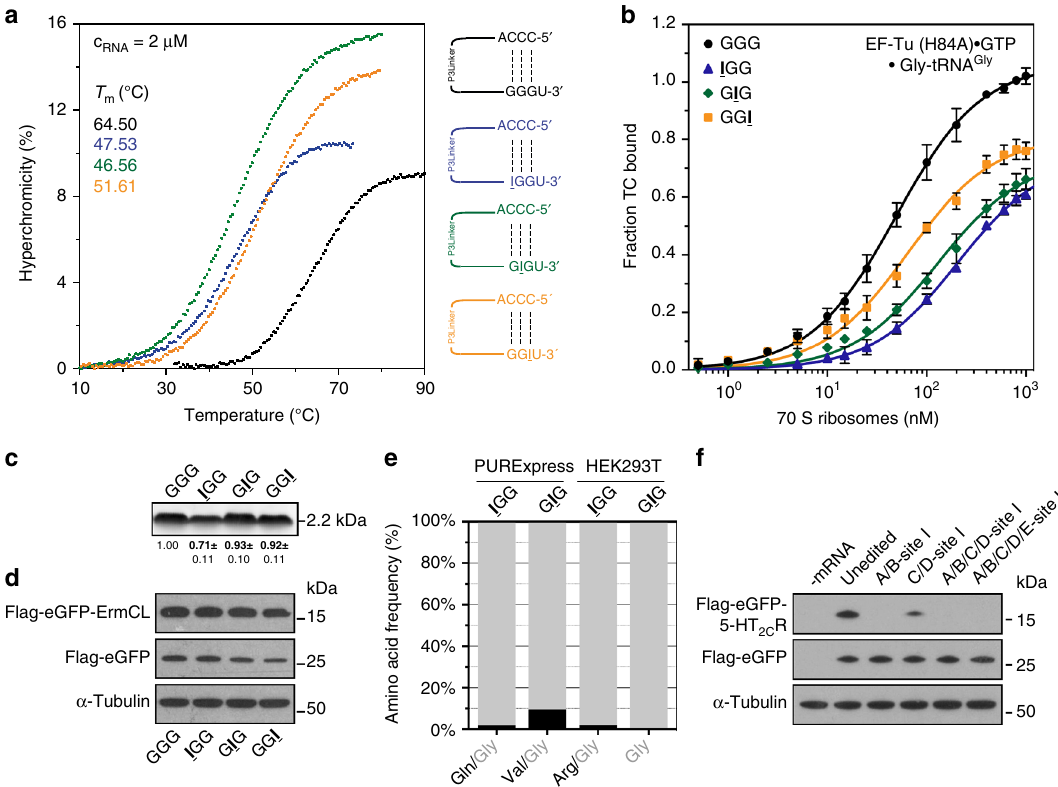
Fig. 5 The in fl uence of inosine on the stability of the codon – anticodon interaction. a Employing a minimal codon – anticodon model, the impact of a single inosine on the stability of the W – C interaction was determined. b The observed position-dependent effects on codon – anticodon interaction could be reproduced using an EF – Tu ternary complex (TC)-binding assay. mRNAs carrying single inosines were translated in c an E. coli translation system and d in HEK293T cells. e The translation products were puri fi ed and qualitatively assessed by mass spectrometry. f An additive inhibitory effect of two or more inosines within the 5-HT 2C R mRNA can be observed. Error bars depict the SDs from the mean of at least three independent